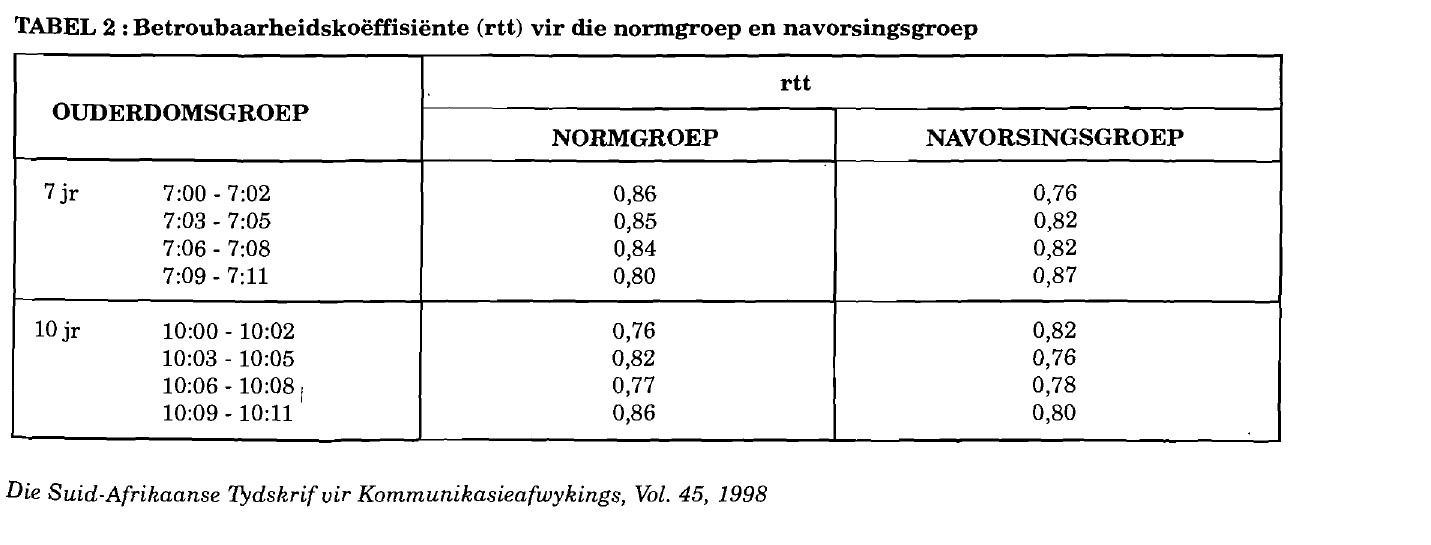
TABEL 2 : Betroubaarheidskoeffisiente (rtt) vir die normgroep en navorsingsgroep